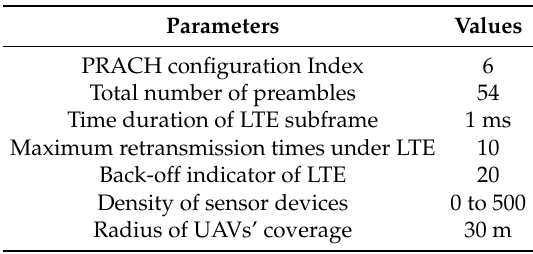
Table 2. Simulation parameter